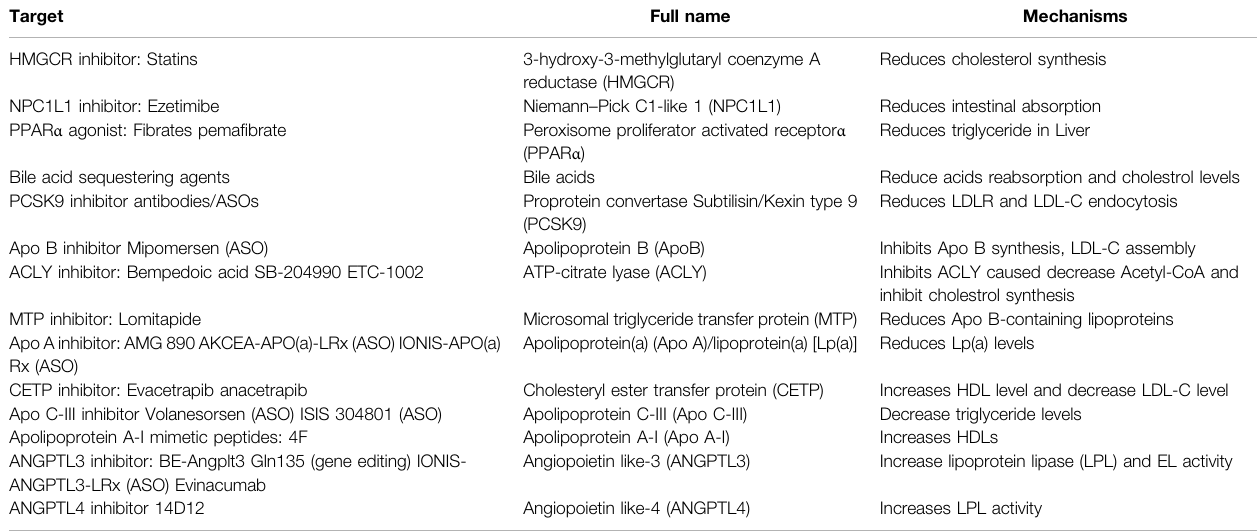
TABLE 2 | Targets in lipid homeostasis for cardiovascular disease